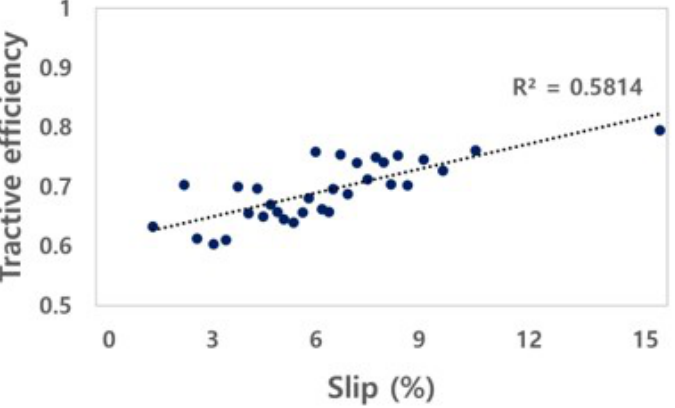
Figure 10. Results of tractive efficiency as slip for the electric AWD tractor during traction test.